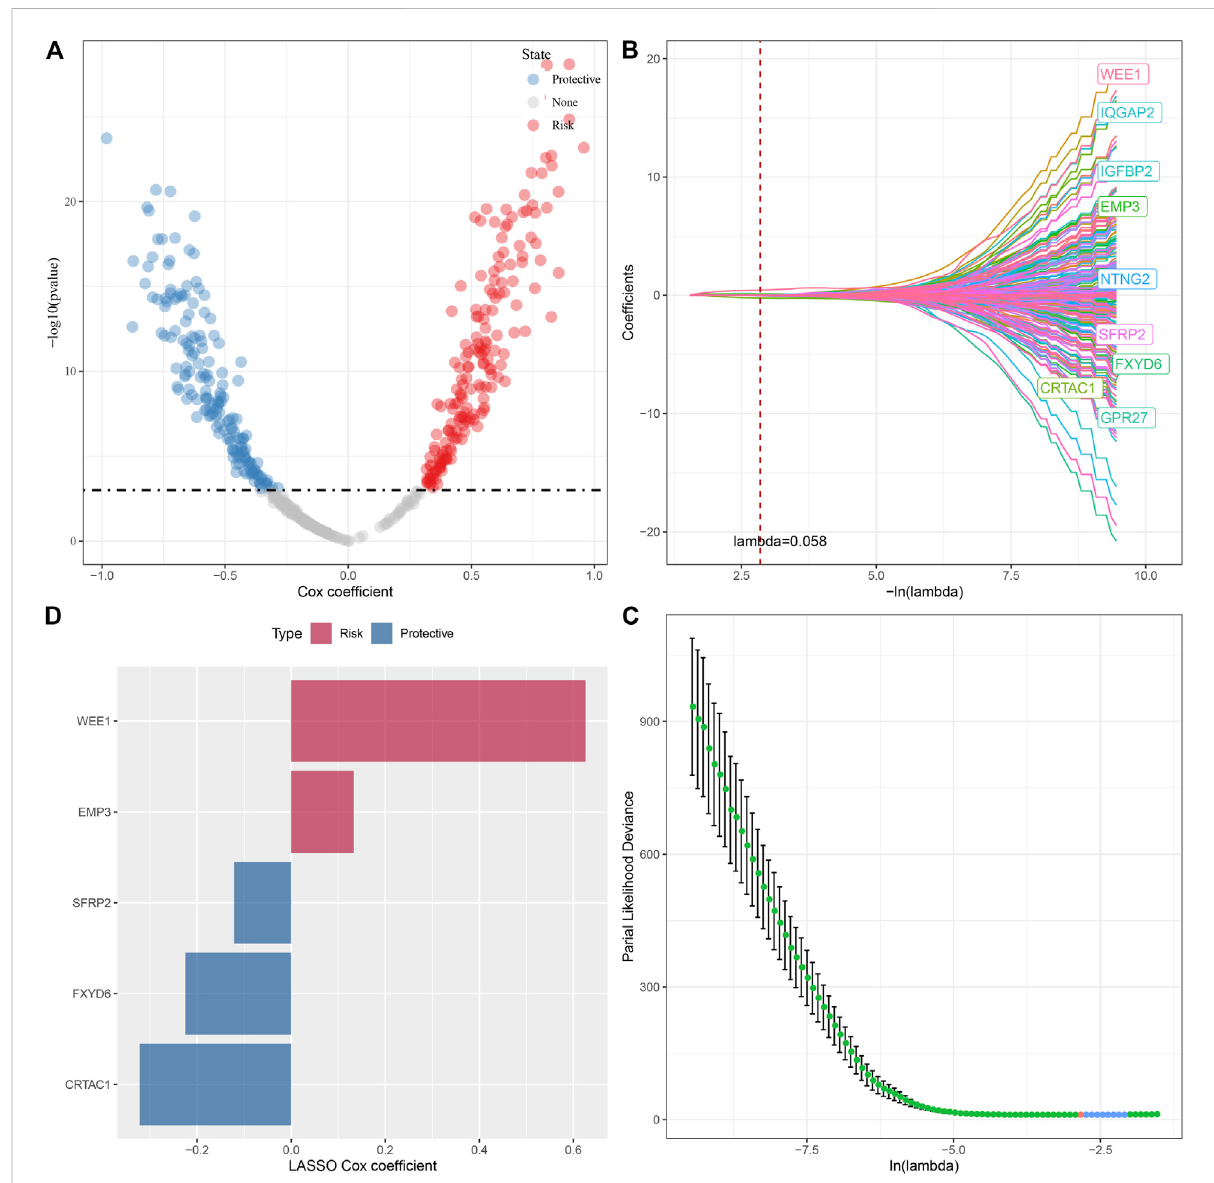
FIGURE 8 Lasso screening of key genes to construct prognostic models. (A) A total of 343 promising candidates were identi fi ed among the DEGs. (B) Trajectoryofeachindependentvariablechangingalongwithlambda. (C) Con fi denceintervalunderlambda. (D) .DistributionofLASSOcoef fi cientsof the glutamine metabolism-related prognostic gene signature: Distribution of LASSO coef fi cients of the glutamine metabolism-related prognostic gene